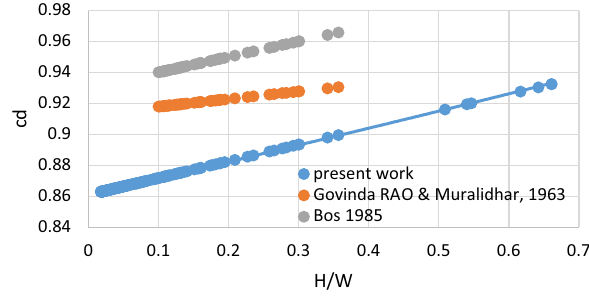
Fig. 5 3D stepped weir, scale 1:10